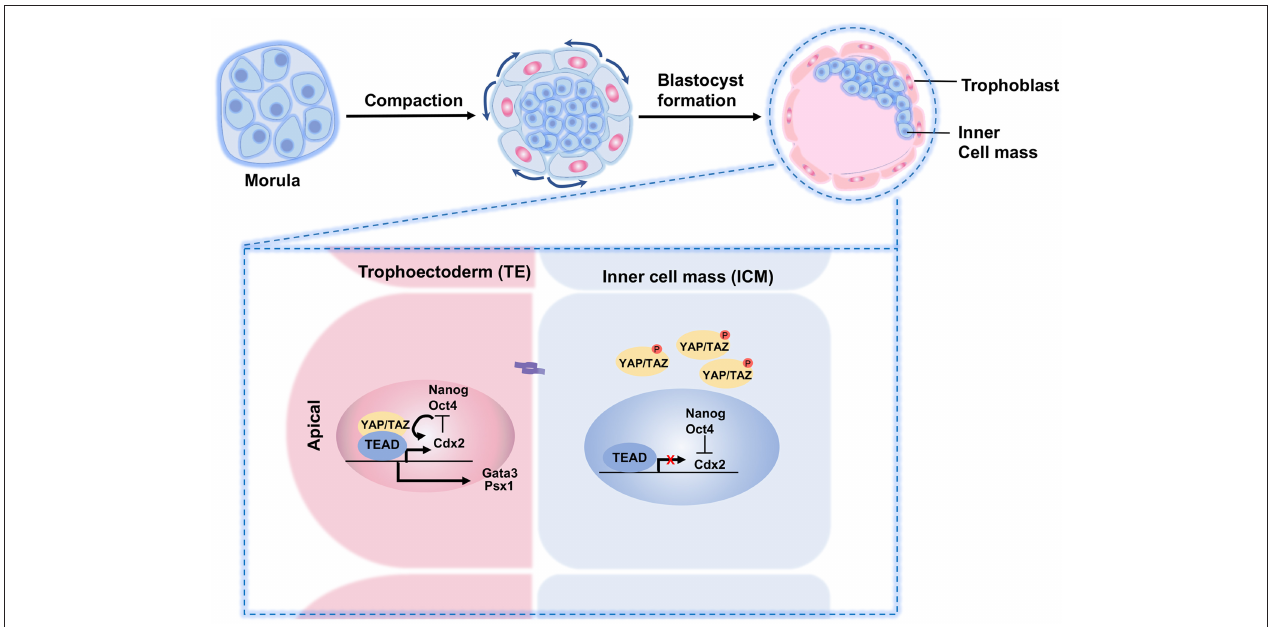
FIGURE 4 | A schematic illustration of YAP/TAZ regulation of TE and ICM specification in preimplantation embryo. During preimplantation, the outer blastomeres of the embryo form an outer epithelial trophoectoderm (TE) that envelopes the remaining blastomere and the inner cell mass (ICM). The Hippo pathway plays a crucial role in the cell fate determination. In the outer cells, nuclear YAP and TEAD4 regulate specification of the TE lineage through activation of the TE-specific genes such as Cdx2 and Gata3. In the inner cells, cell-cell adhesions influence the Hippo signaling. Activated Hippo pathway impairs YAP nuclear localization in the ICM lineage, thereby limiting TEAD4 transcription and abrogating the expression of outer TE-specific